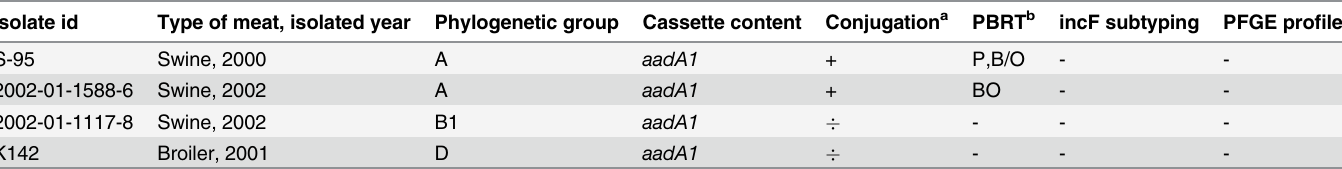
The isolates were recovered from Norwegian produced meat.